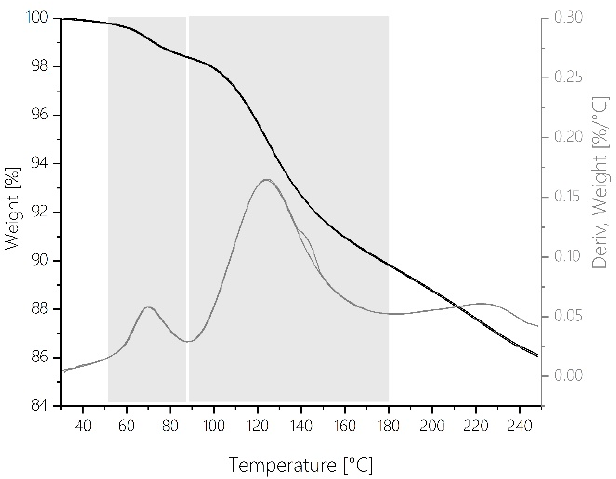
Figure 4 . Weight changes during MF resin cure in dependence of temperature in absolute values and first derivative as recorded by thermogravimetric analysis using a temperature gradient of 2 °C min − 1 .